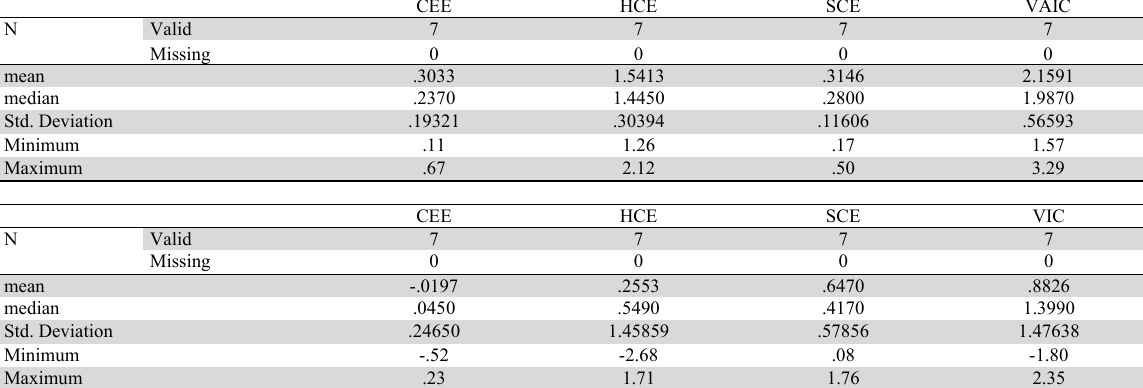
The information of some descriptive staitsics for SCA and UCA groups